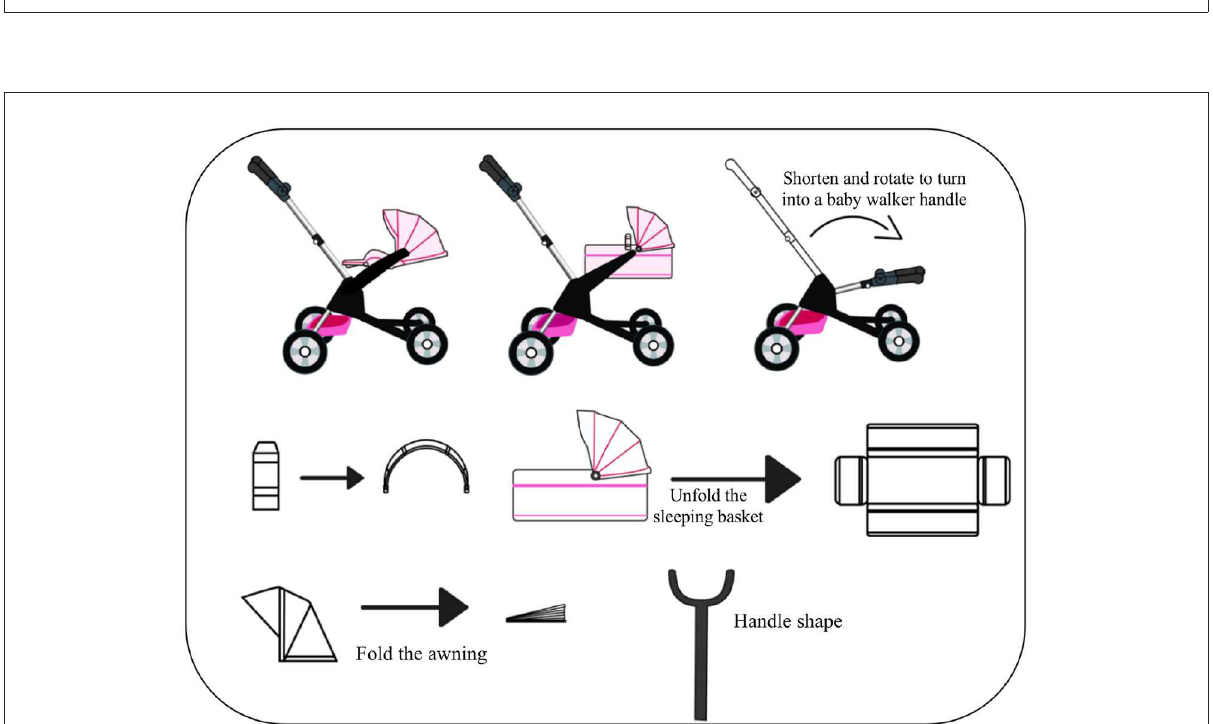
FIGURE4 Detailed